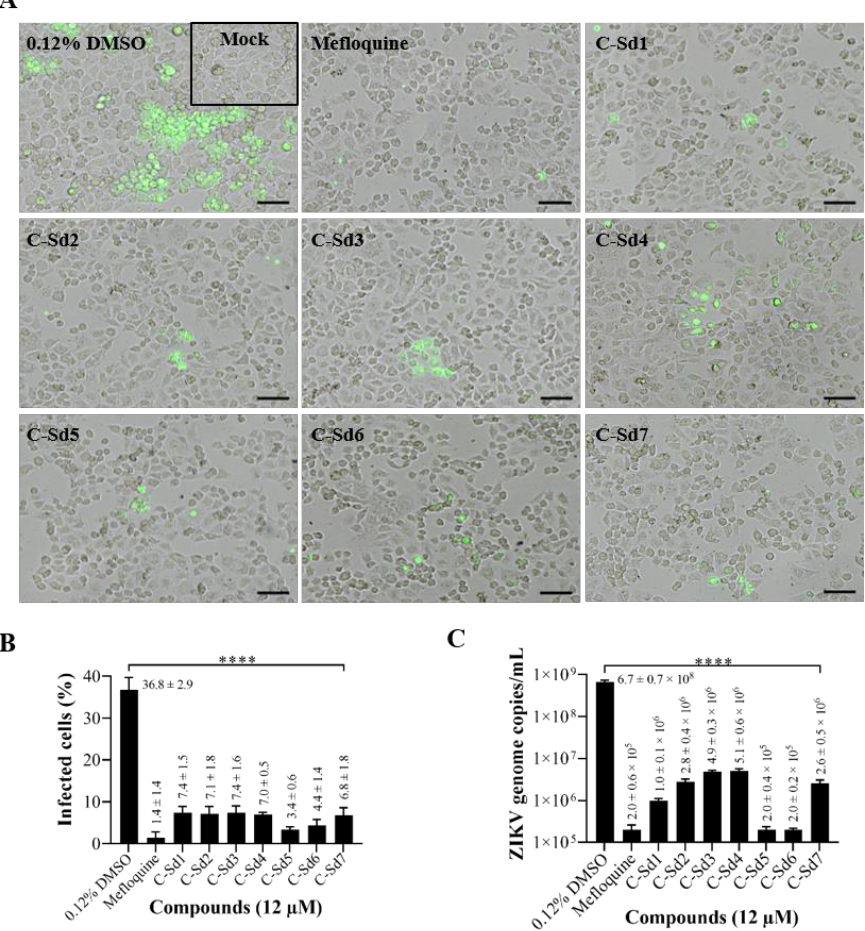
Figure 3. Evaluation of the C-Sds antiviral effect by immunofluorescence and RT-qPCR. The cervical cells were mock-infected or ZIKV-infected at MOI 10 and treated with 12 µ M of C-Sds or mefloquine for 48 h. The images are shown in DIC (differential interference contrast) microscopy; ( A ) fluorescent intracellular staining shows the ZIKV–envelope glycoprotein (green). The graphs represent the mean ± standard deviation of ( B ) the percentage of infected cells and ( C ) copies of the ZIKV genome/mL. The data are representative of 3–5 experiments run in duplicate. The statistical significance was determined by one-way ANOVA, followed by Dunnett’s multiple-comparisons test. **** p < 0.0001 for all C-Sds compared to control. Bars, 50 µm.